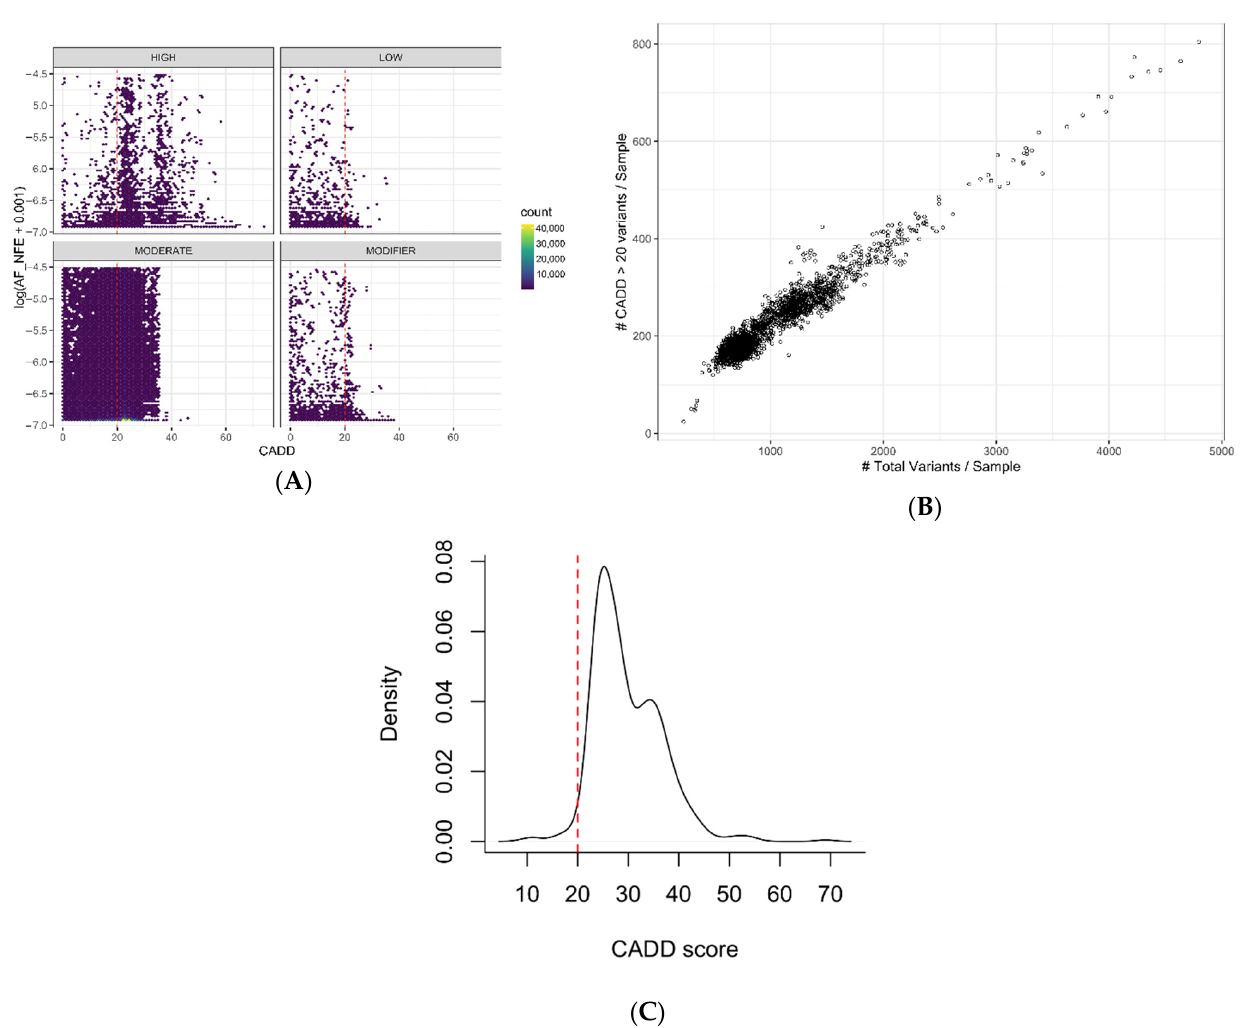
Figure 4. Variant conservation score: ( A ) Hexagonal heatmap of variant frequency related to the CADD score, grouped by the SnpEff impact classes (Supplementary Table S2). ( B ) Scatterplot of variants with high CADD scores (>20) related to total variants per sample. ( C ) Distribution of CADD scores of detected causative variants (n = 807). The red lines represent a CADD score of 20. AF_NFE stands for allele frequency_non-Finnish European population (gnomAD). Table 1. Variants conservation score according to its impact class .